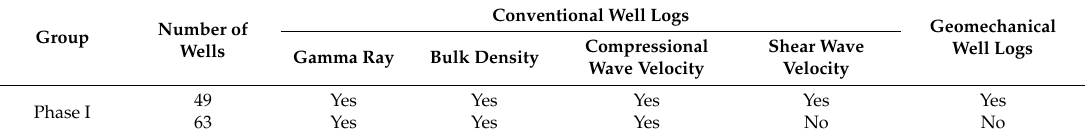
Table 1. Data available for the prediction of Shear Wave Velocity.